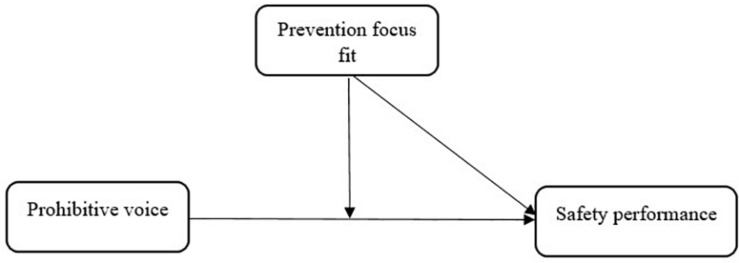
Conceptual model.